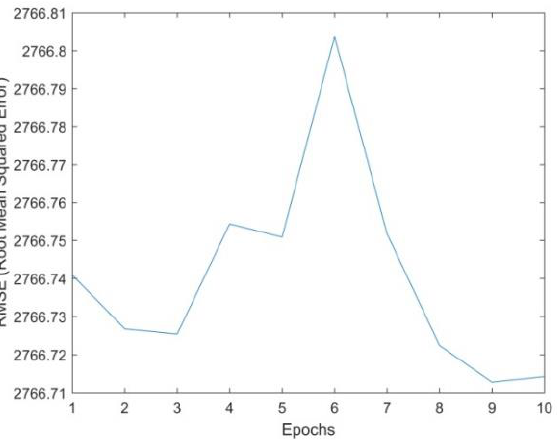
Figure 8. Root Mean Square Error (RMSE) as a function of epochs for the prediction model.